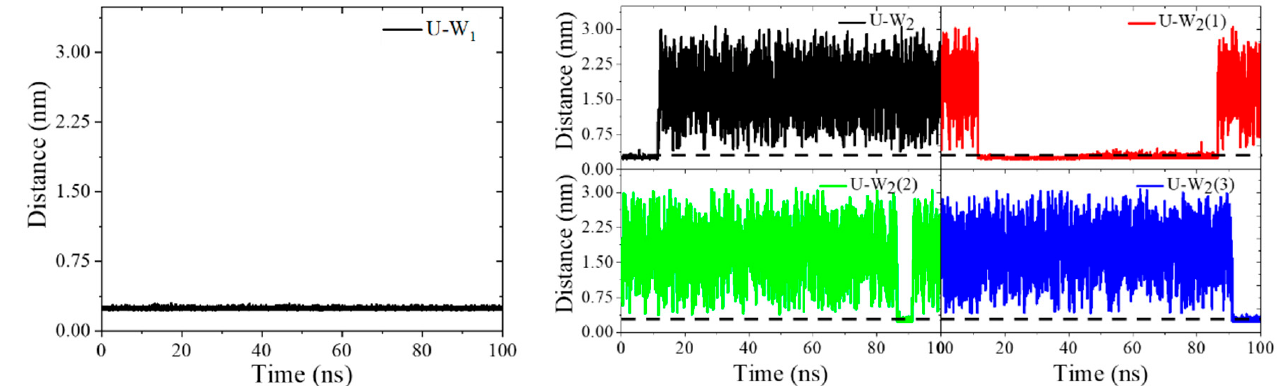
Figure 9. The time evolution of the distances between U 4+ and the coordinating water molecules during the simulation. The right figure shows the exchange of the second coordinating water ligand (W 2 ) with three additional water molecules (W 2 (1), W 2 (2) and W 2 (2)). The dash line in the right figures designates the U-O W distance of 0.3 nm.